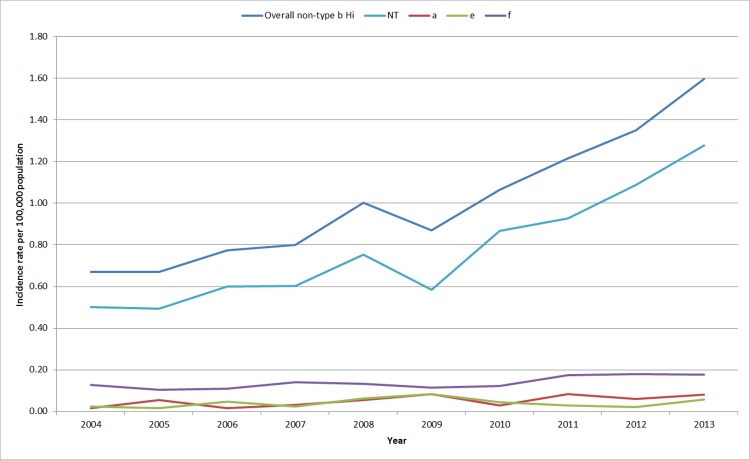
Incidence rate of invasive non-type b Hi by serotype in Ontario, 2004–2013 (n = 1,307).